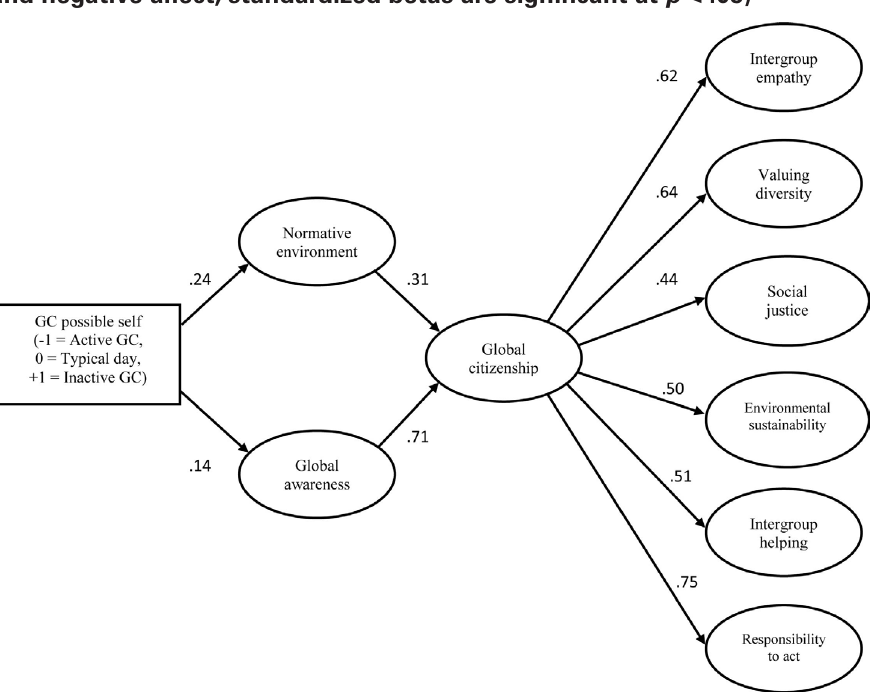
Figure 1. Influence of ‘possible self’ manipulation on antecedents, identification, and outcomes of global citizenship (controlling for positive and negative affect; standardized betas are significant at p <